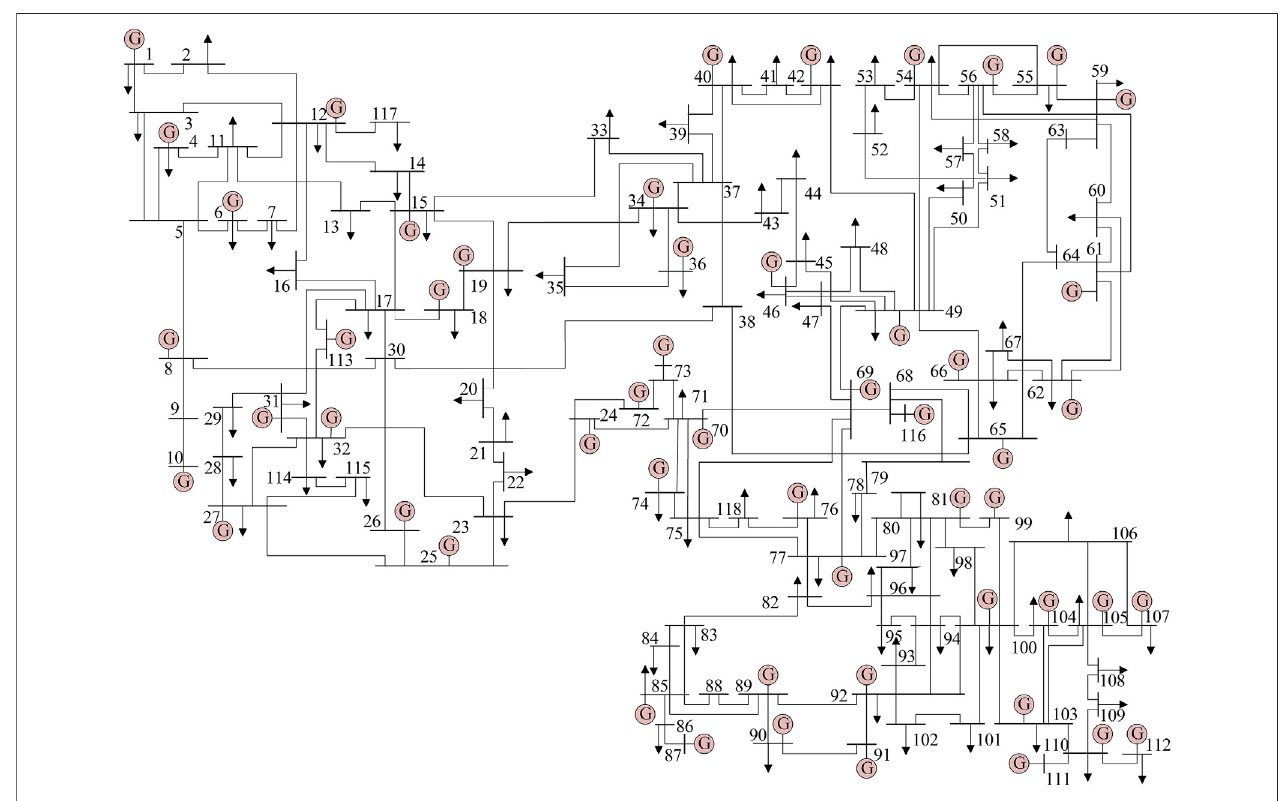
FIGURE 5 | Topology of the IEEE 118-bus system.